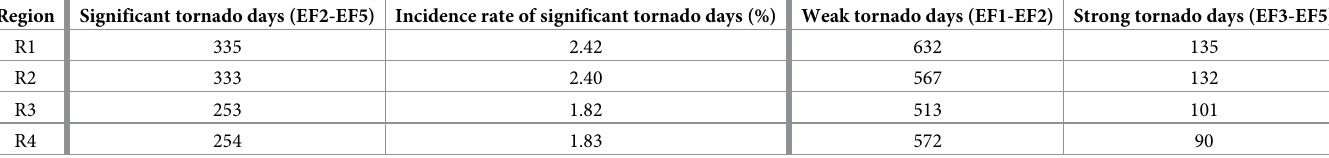
Table 1. Number of significant, weak and strong tornado days for each of the four regions from 1980 to